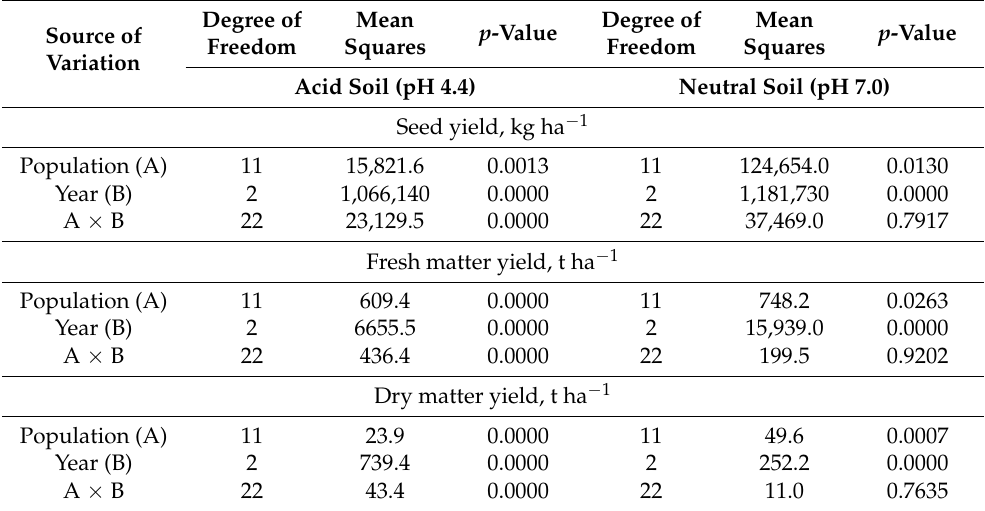
Table 3. The ANOVA results by year under different experimental sites and their effect on seed yield and fresh matter and dry matter